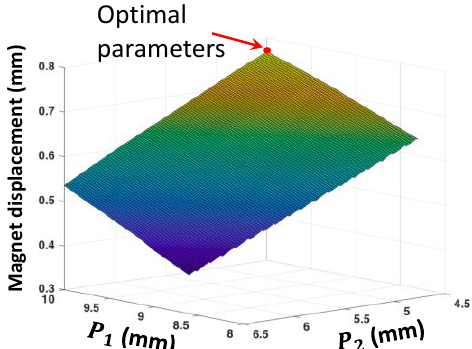
Figure 7. Optimisation result: a surface plot of magnet displacement versus hollow radius P 1 and magnet position P 2 . The optimal parameters were found at the boundaries of the parameter design space. Table 1. Simulated results of feature point displacement with different parameter values.